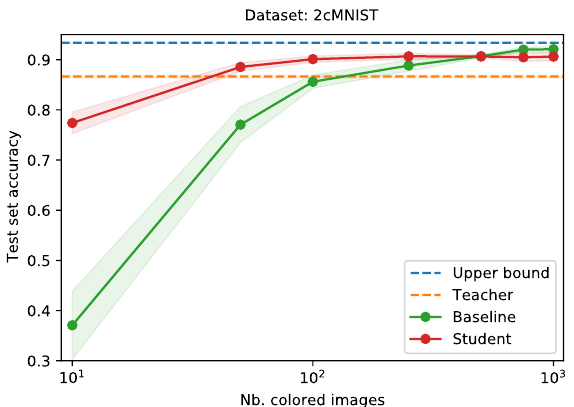
Figure 3. Comparison of the average test set accuracy when training a neural network, with and without knowledge distillation, as a function of the student train set size. Averages over three runs. Shaded areas indicate the standard